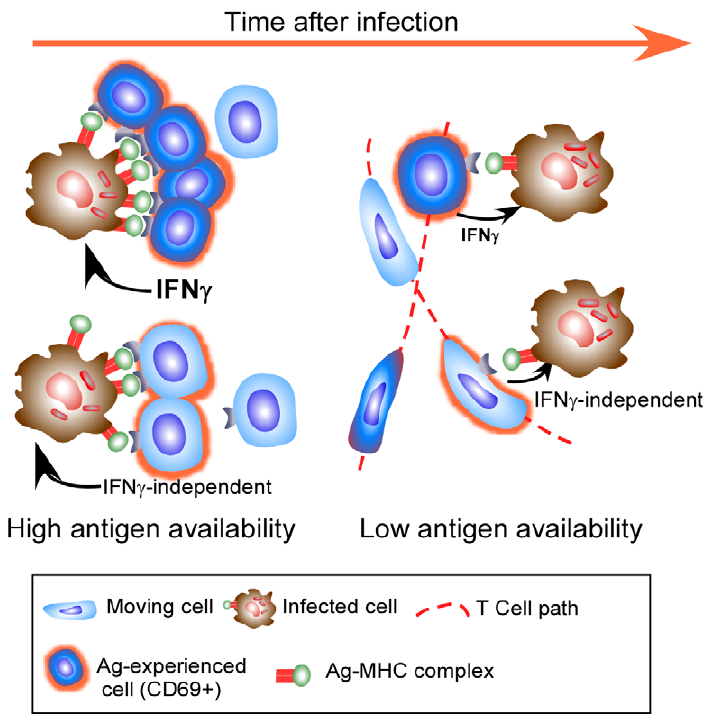
Figure 1. Effector T cells do not find the granuloma to be a stimulating environment. Effector T cells enter the granuloma and only a few exhibit significant migration arrest (dark blue cells) and targeted release of IFN c , likely when they encounter a high level of cognate antigen on infected phagocytes. As their cognate antigen is reduced, even fewer cells undergo migration arrest, with many more cells continuing to move throughout the granuloma (light blue motile cells). Although these cells do not stop migrating, they do up regulate CD69 in an antigen-specific manner. Cells entering the granuloma may mediate their effector function without the release of IFN c , and while this activity does require recognition of antigen, it may not need migration